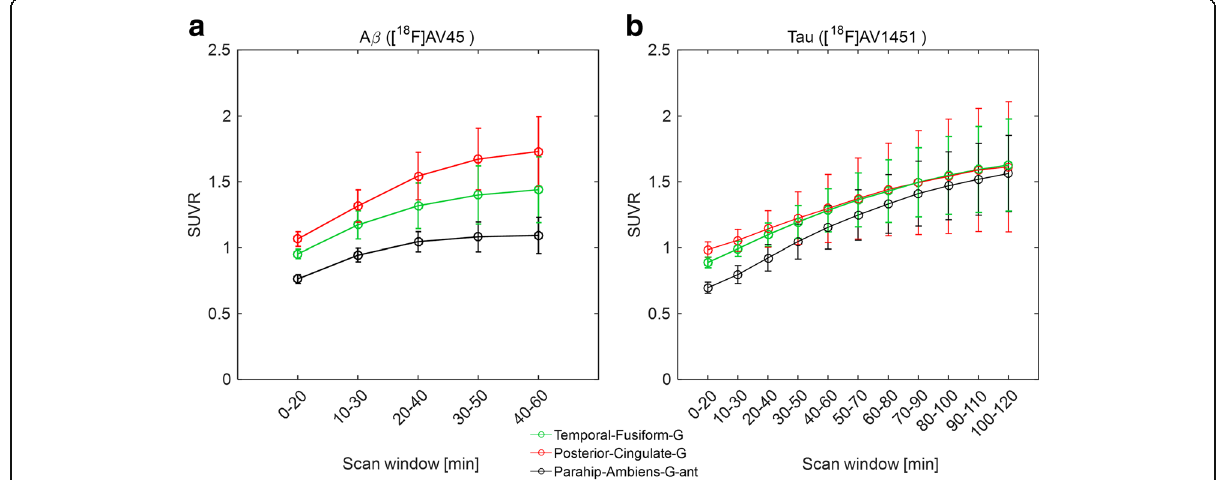
Fig. 4 Time stability of mean SUVR values over all subjects with cerebellum grey as reference region for 20 min time windows over the whole scan duration for A β ( a ) and tau ( b ) scans for three example